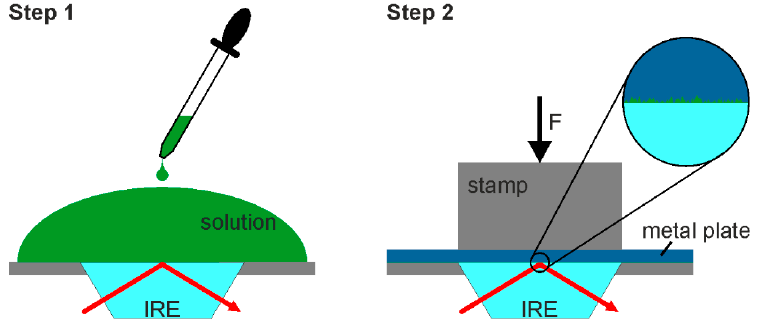
Figure 1. Schematic of the experimental procedure. IRE = internal reflection element; F = force.